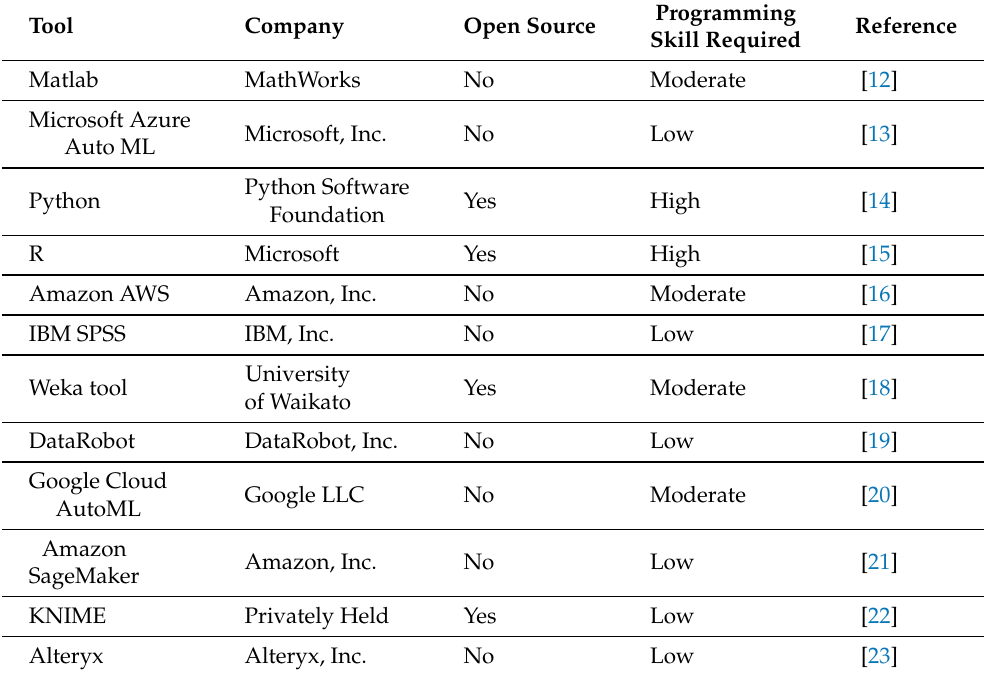
Table 1. Some of the machine learning tools and supporting programming languages available.